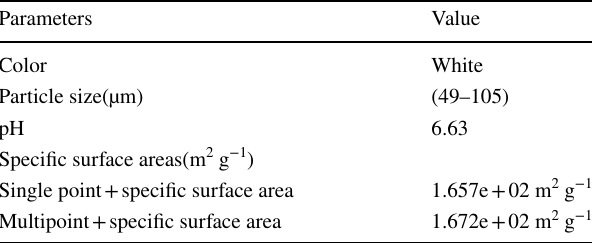
Table 2 Some properties of the clay sample used in the work Parameters